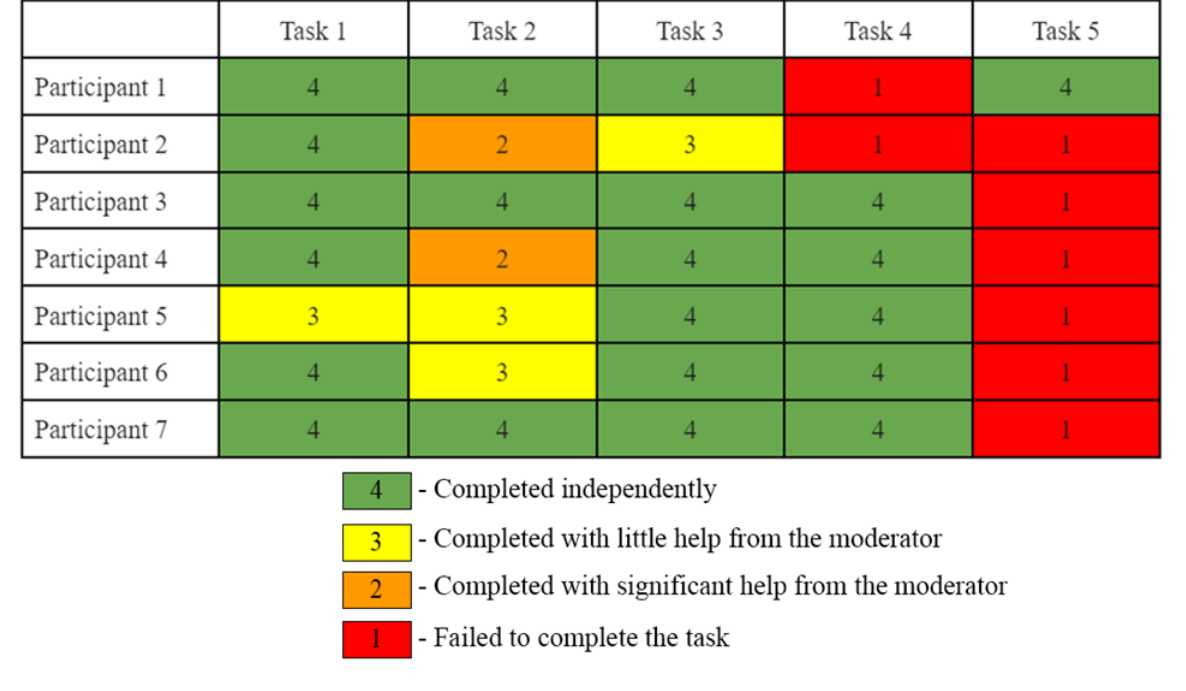
Figure 2 : Task Success